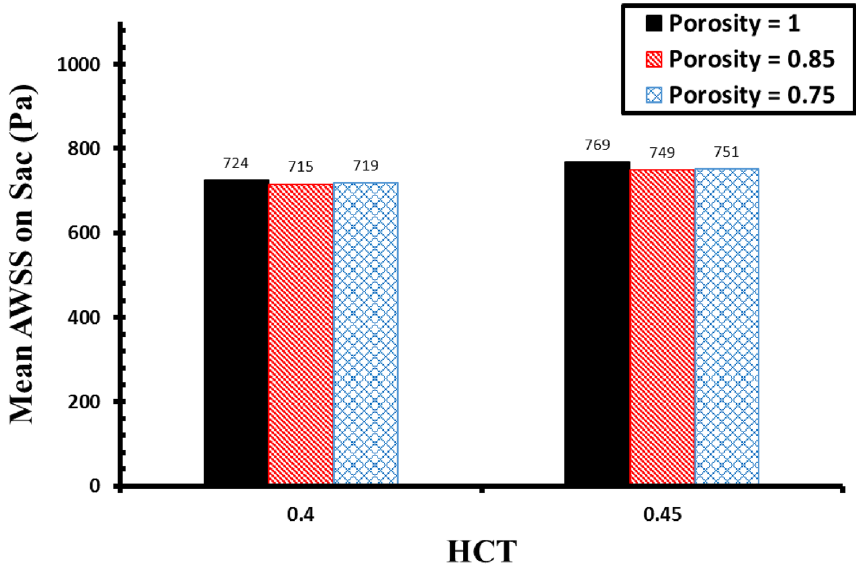
Figure 11. Impacts of HCT and coiling porosity on Mean AWSS on sac surface.